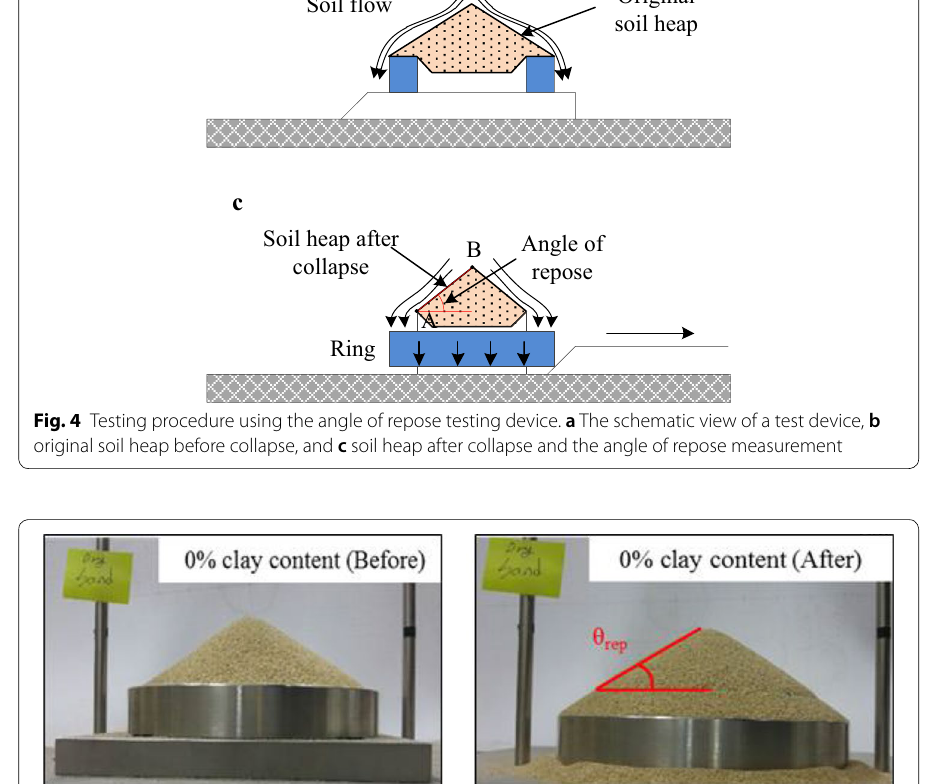
apparent cohesion was sufficiently small. The failure envelopes were divided into two different ranges of clay contents: envelopes with clay contents of 10% and lower, and to be 35.7° for pure sand (CC 0%), and inclined to peak value (38.7°) at clay content of = 10%. At higher clay contents, the internal friction angle gradually decreased to 34.0° at clay content of 30%.